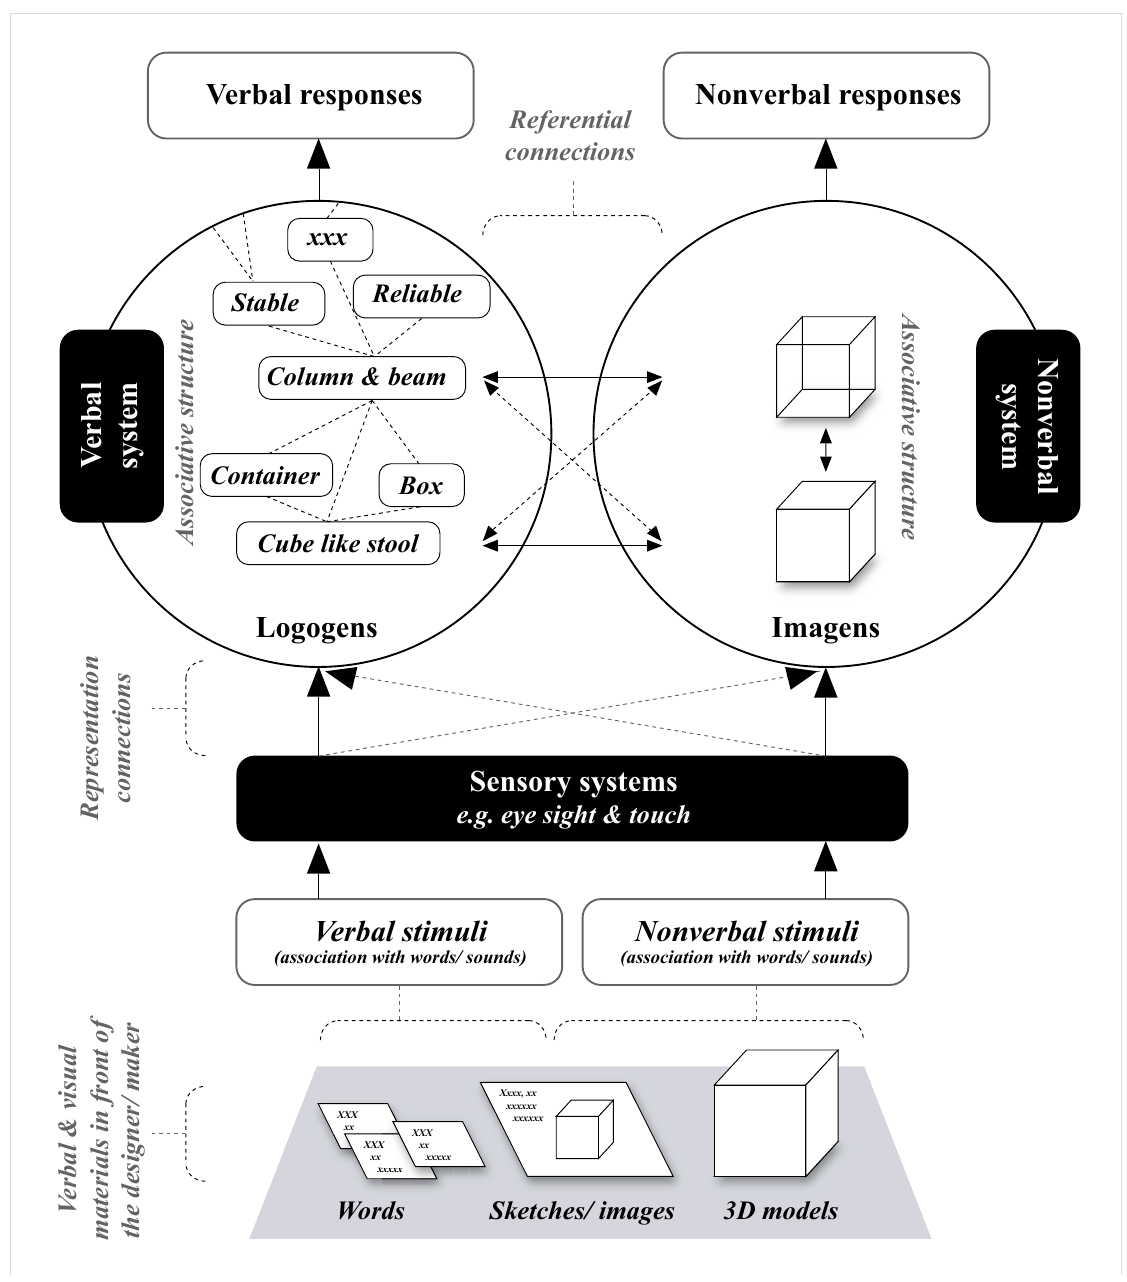
Figure 2 : This diagram illustrates the dual coding mechanism modified from Allan Paivio’s theory (Paivio 1986). This indicates two cognitive subsystems sensing verbal and visual materials respectively. Verbal coding interprets lologens associations and hierarchies. Visual coding interprets part-to- whole relationships within imagens. Source: